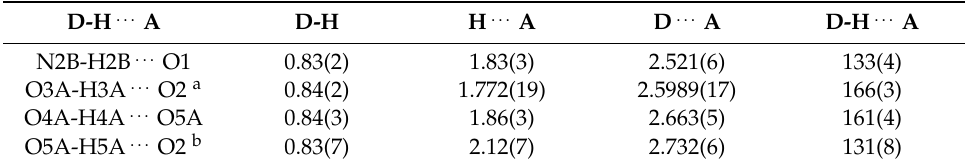
Table 5. Hydrogen bond geometry in 4 (Å, ◦ ). Table 5 . Hydrogen bond geometry in 4 (Å,°).